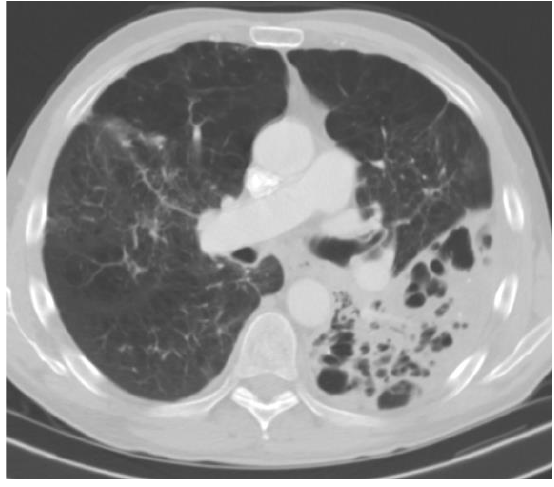
Figure 6. Chronic cavitary pulmonary histoplasmois. Multiple thick wall cavitations in a patient with emphysematous disease.